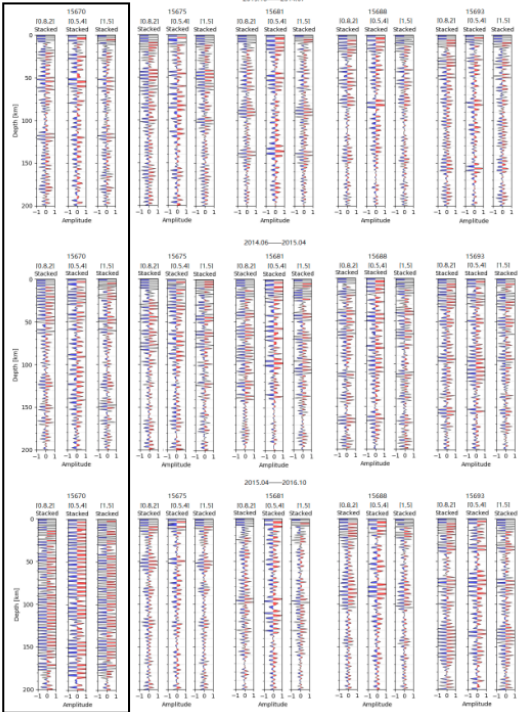
Figure 12. L6 (from left to right: 15618, 64052, 64054, 64051, 15716, 15717, 15718, 15719 and 15720)